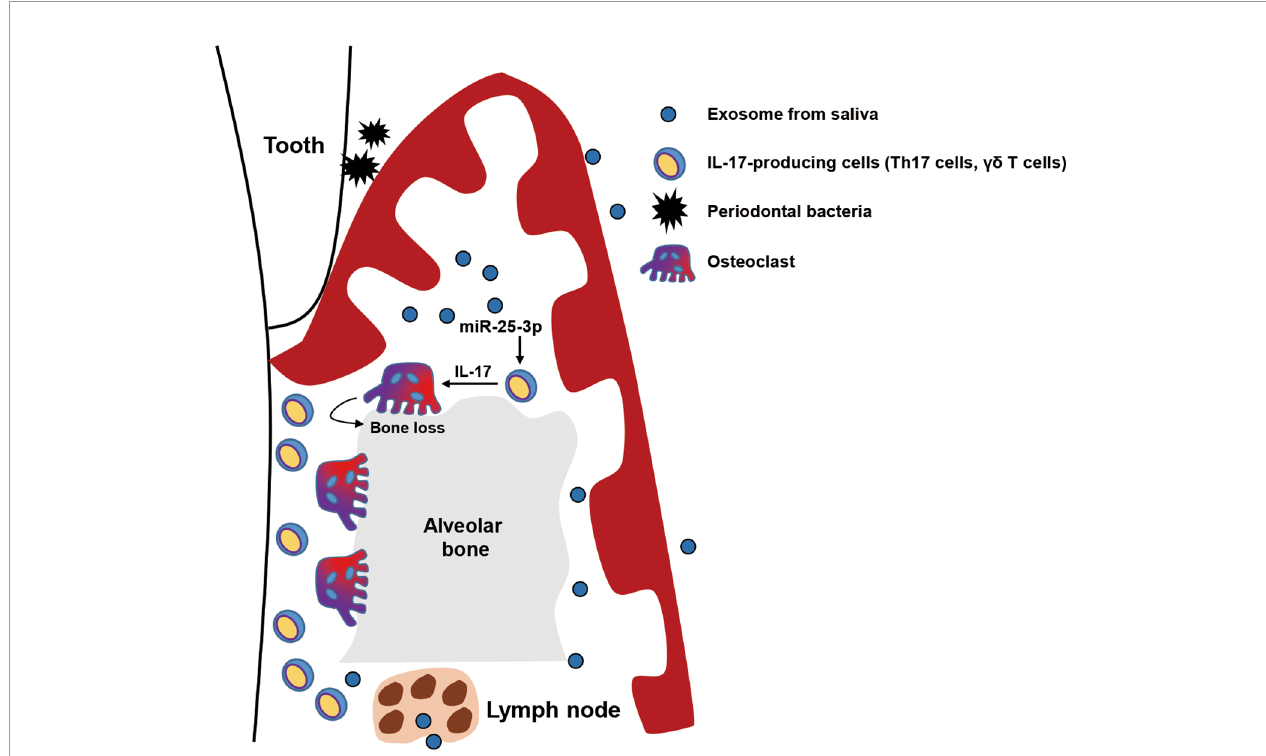
FIGURE 5 | Graphical abstract. Exosomal miR-25-3p in saliva is highly enriched in patients with type 2 diabetes. Salivary exosomal miR-25-3p promotes local in fl ammation and periodontal bone loss in mice by activating T H 17 cells and gd T